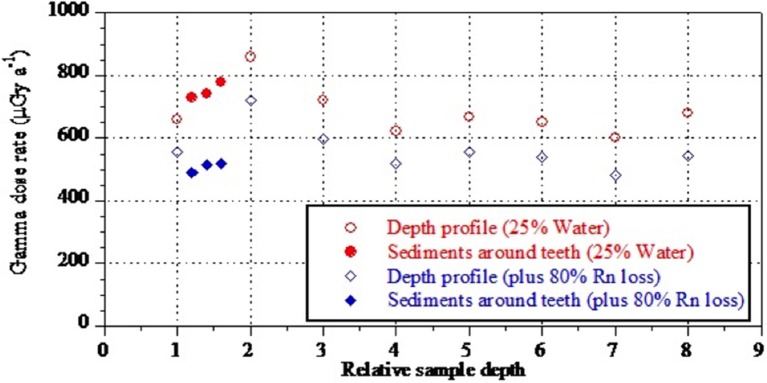
Gamma dose rate reconstructions derived from analytical data of sediment samples collected around ESR samples 1767, 1788 and 1810 (closed circles and diamonds), combined with samples from a vertical profile in the excavation pit and sondage (open circles and diamonds).The data show little variation in dose rate with depth (see text for explanation).